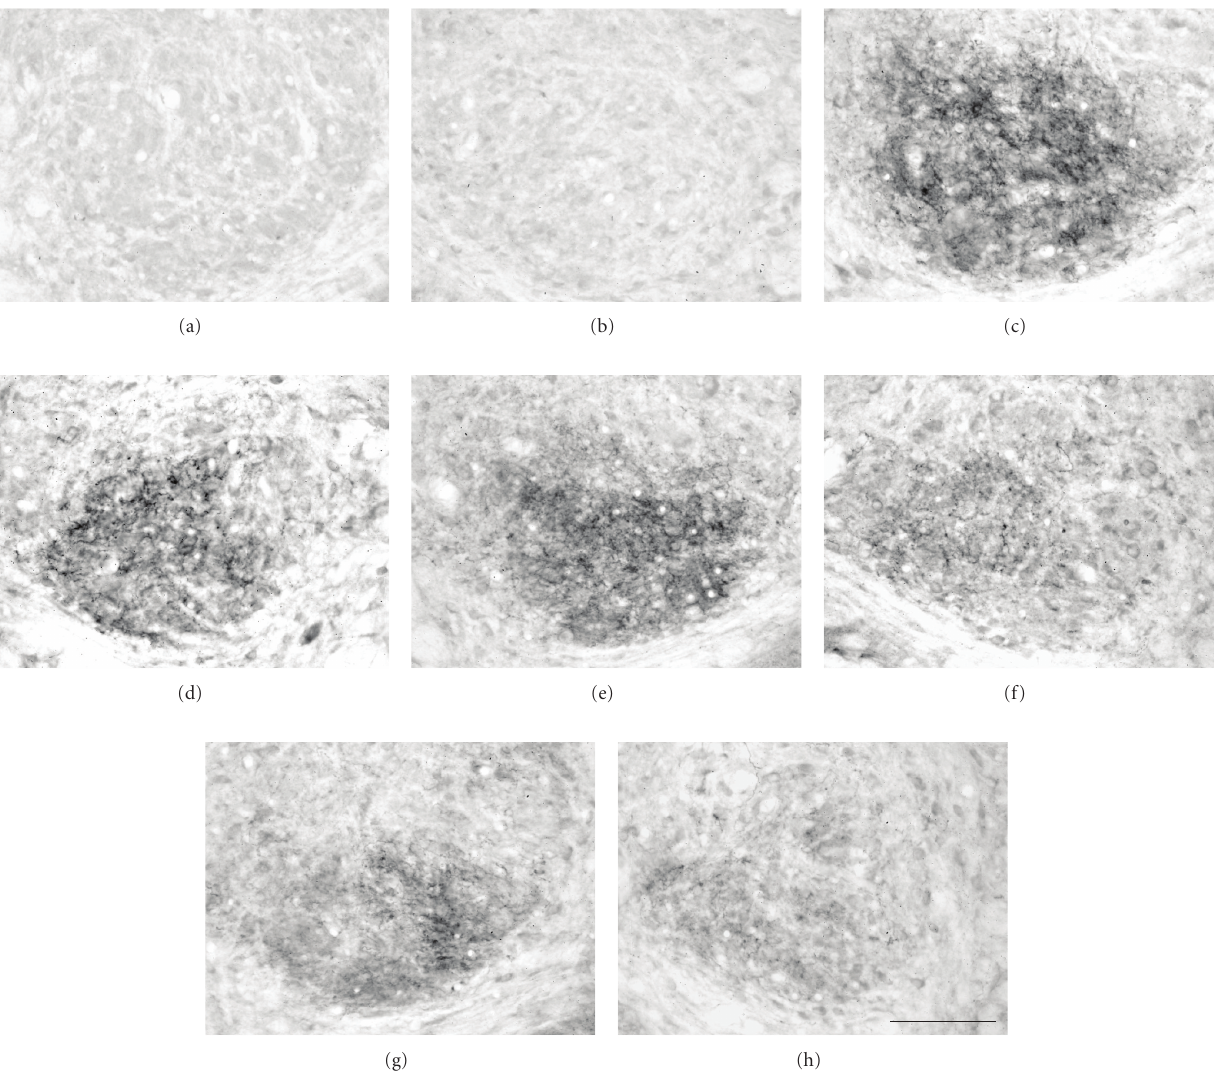
Figure 4: Photomicrographs showing NPY-LI fibers in the middle region of the ipsilateral CN four weeks after chronic constriction injury in control (a, b) or four weeks after CCI without (left panel) or with (right panel) electrical stimulation in presaline (c, d), 1% (e, f), and 5% (g, h) lidocaine pre-treatment groups. Bar = 100 μ